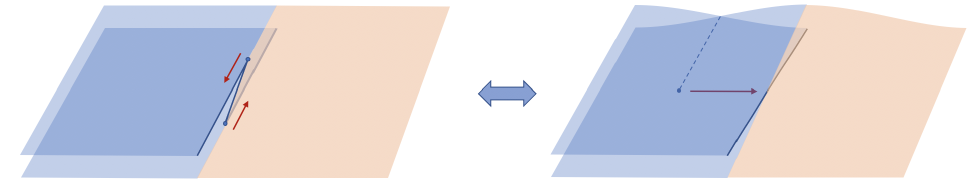
Figure 11. The transition in which a pair of boundary intertwining operators collide and form a bulk Z 2 twist operator. Again, dark edge lines indicate the locus of reflecting boundary conditions, while the absence of such a dark line at the boundary between M + (blue) and M − (red) indicates the locus of transparent boundary conditions. The bulk interaction on the right-hand figure is a transition of the sort depicted in figures 7 and 10; the reflecting boundary condition lives entirely on one copy of M + , while the other copy of M + transmits into the copy of M − all along its